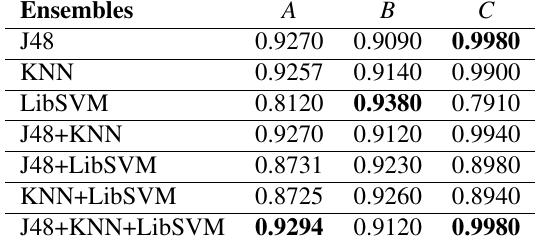
(In Table 6, DS1 represents DATASET1 , DS2 rep- resents DATASET2 and DS3 represents DATASET3 ).